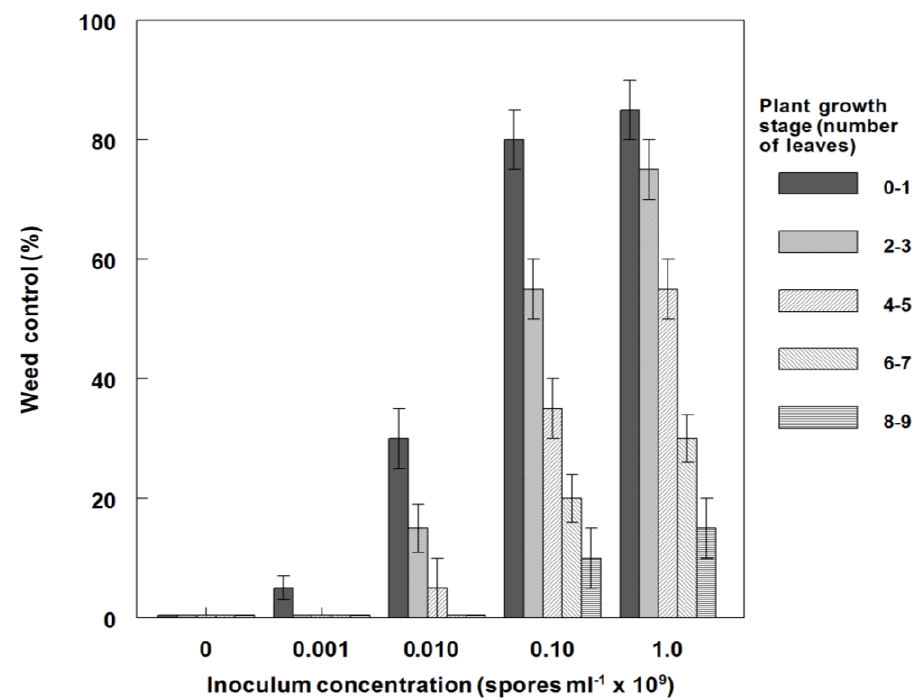
Figure 6. Effect of plant growth stage on weed control (mortality) of spreading dayflower inoculated with P. commelinicola at various inoculum concentrations under greenhouse conditions. Error bars represent Fisher’s LSD ( p = 0.05).